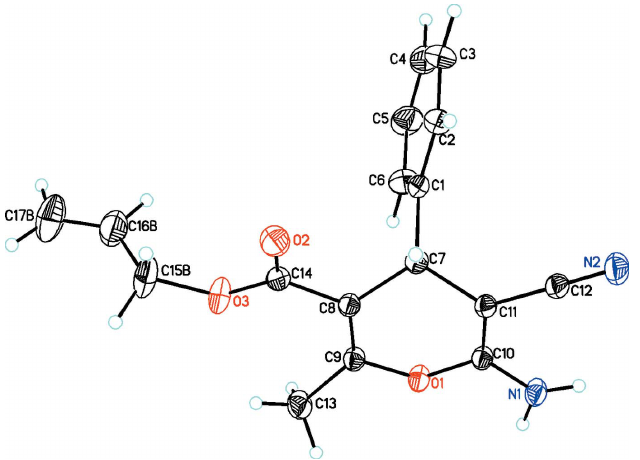
Figure 1 The molecular structure of the title compound with displacement ellipsoids drawn at the 20% probability level (only the major disorder component of the allyl side chain is